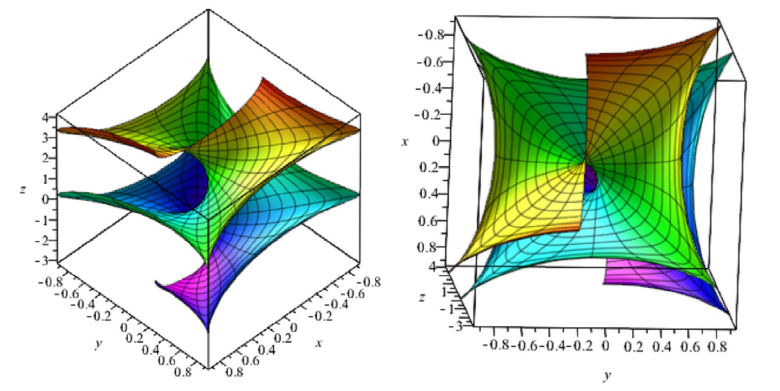
Figure 1. Two views of the helicoidal surface of value ( 0,1 ) , ϕ ( r ) = r 2